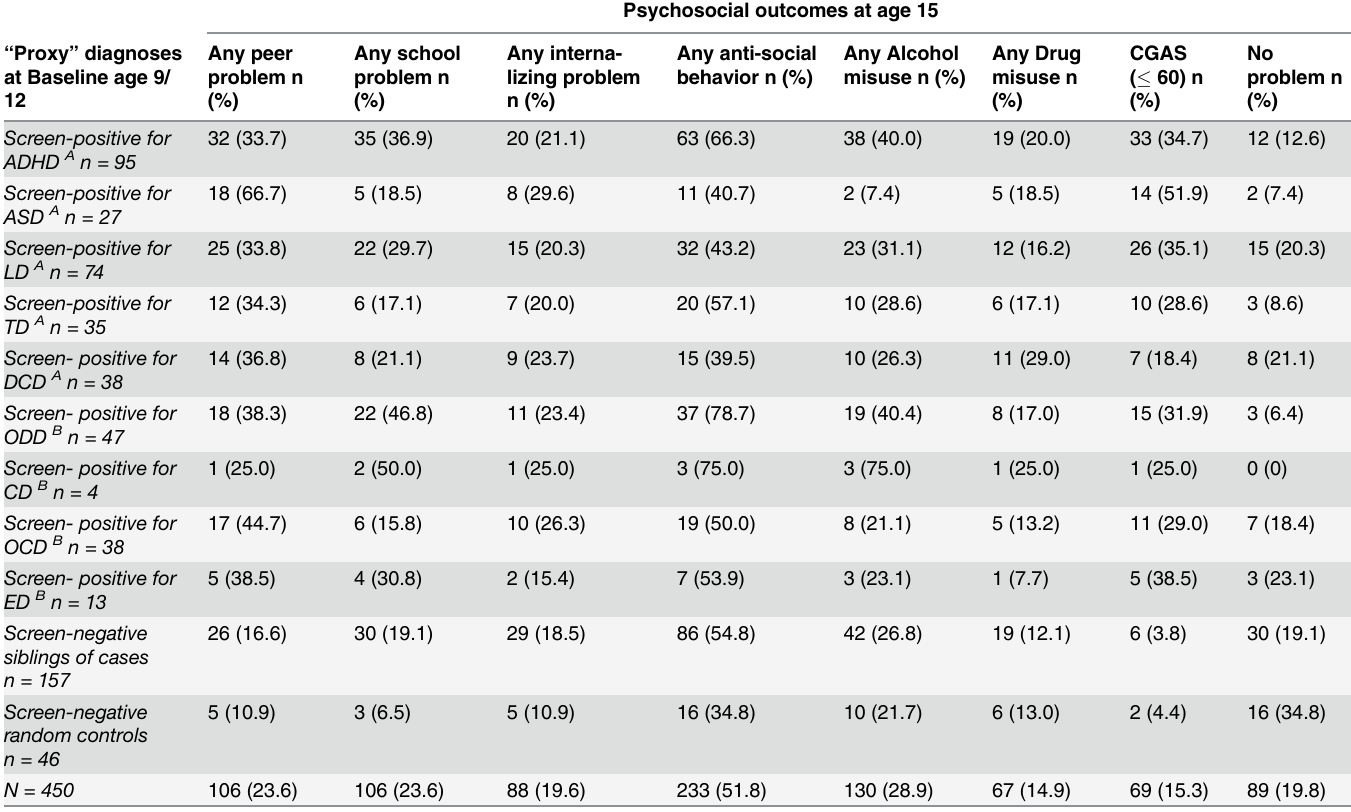
Table 3. Screen-positive cases according to A-TAC, screen-negative siblings, and random, screen-negative controls compared to the psychoso- cial outcomes at age 15. Baseline : CATSS-9/12 study (n = screen-positive in A-TAC for “ proxy ” diagnosis). Follow-up : Psychosocial outcomes in the clini- cal follow-up study,